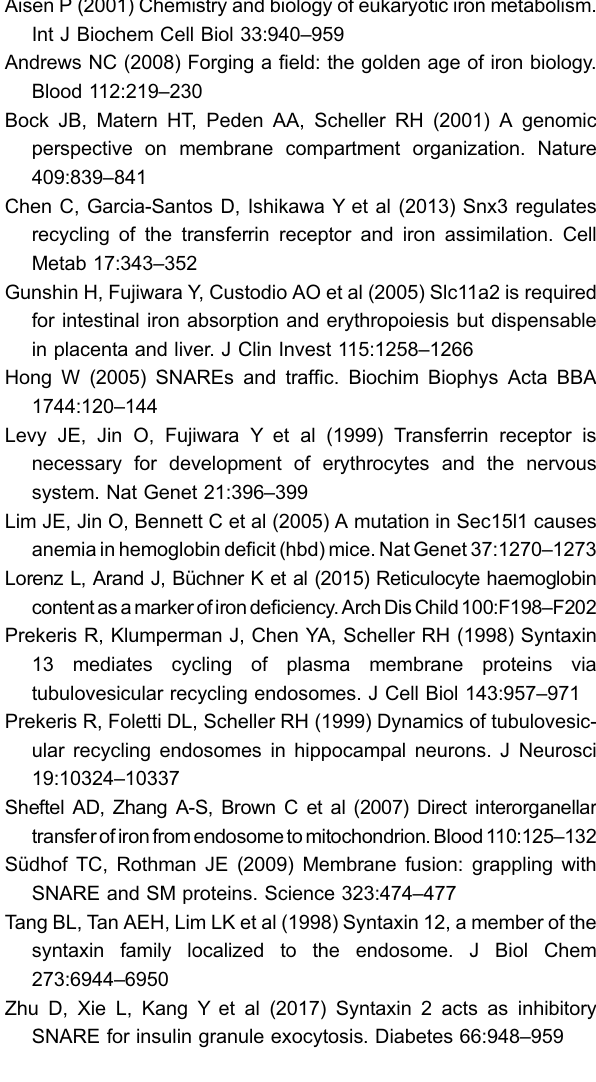
b Figure 2. Fast recycling de fi ciency of transferrin receptor in Stx-t − / − MEF . (A) Colocalization of STX-T (red, RFP tagged) with TFR (green, GFP tagged) in double transfected MEFs